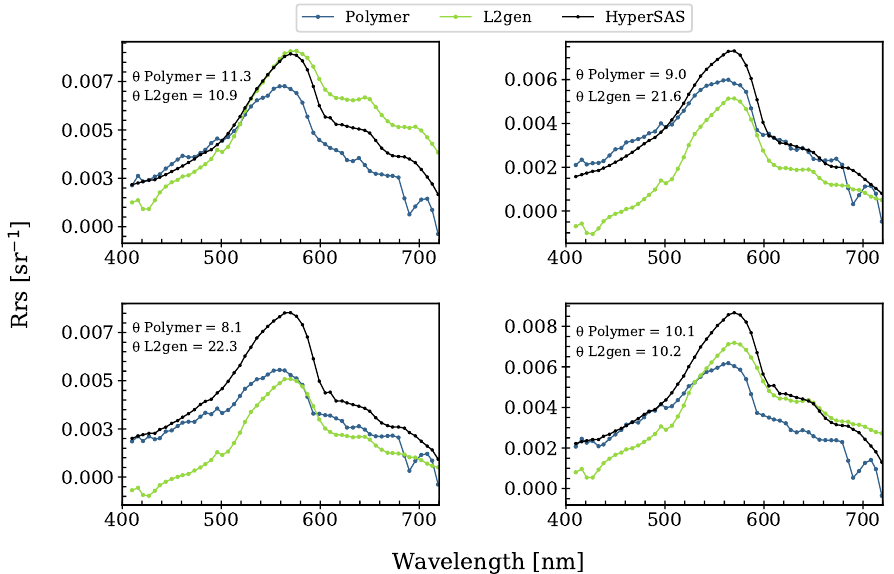
Figure 8. Spectra of coincident match-ups of HICO-Polymer, HICO-L2gen, and HyperSAS for the 410–719 nm spectral range (N =